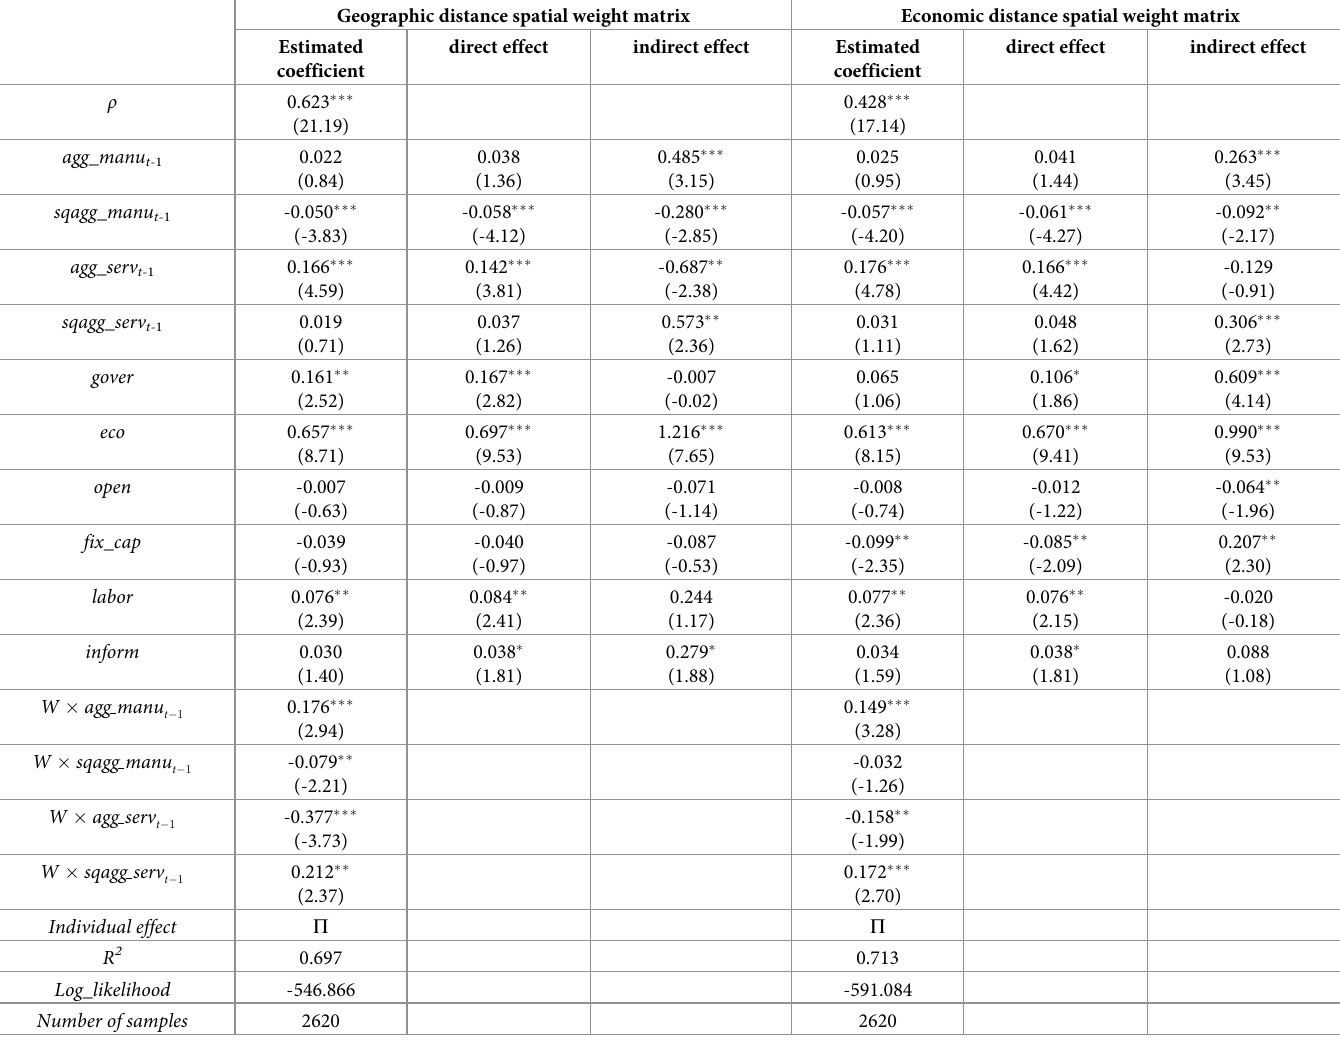
Table 6. Threshold effects of industrial agglomeration on local urban